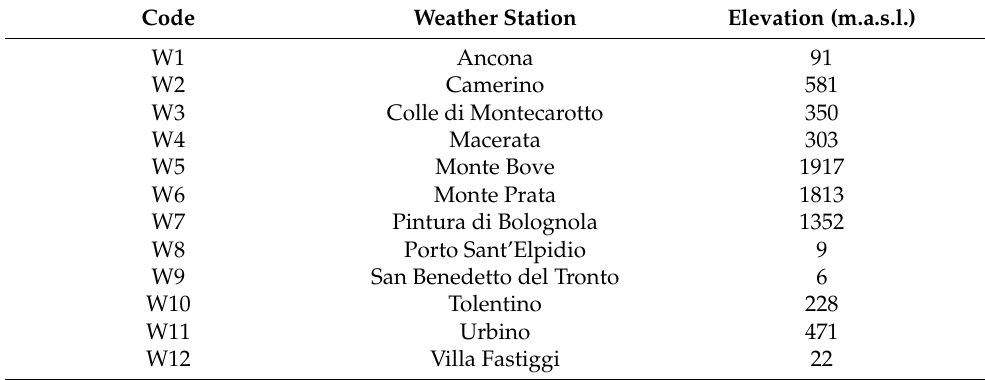
Table 1. Weather stations for the calculation of ET0 using the PM